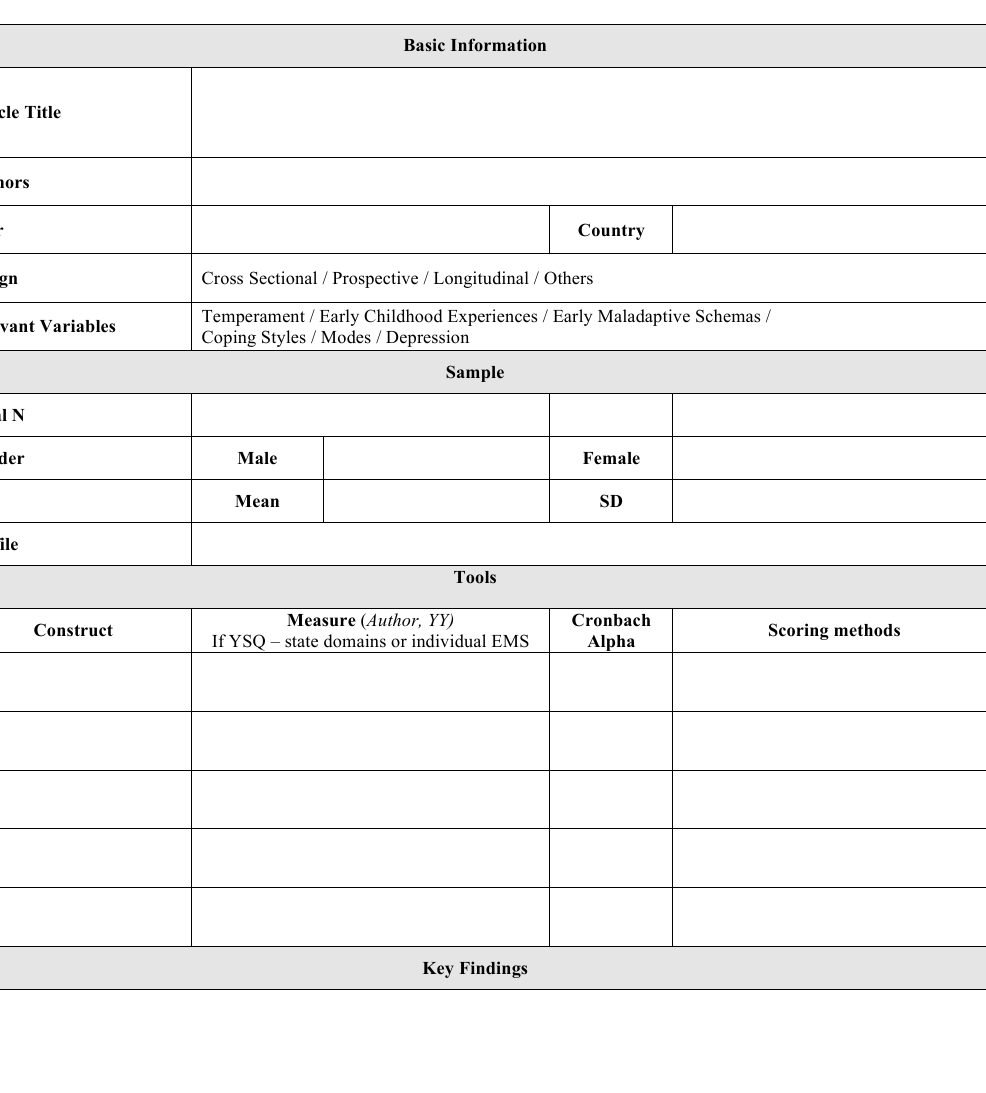
Figure 3. Data extraction form.